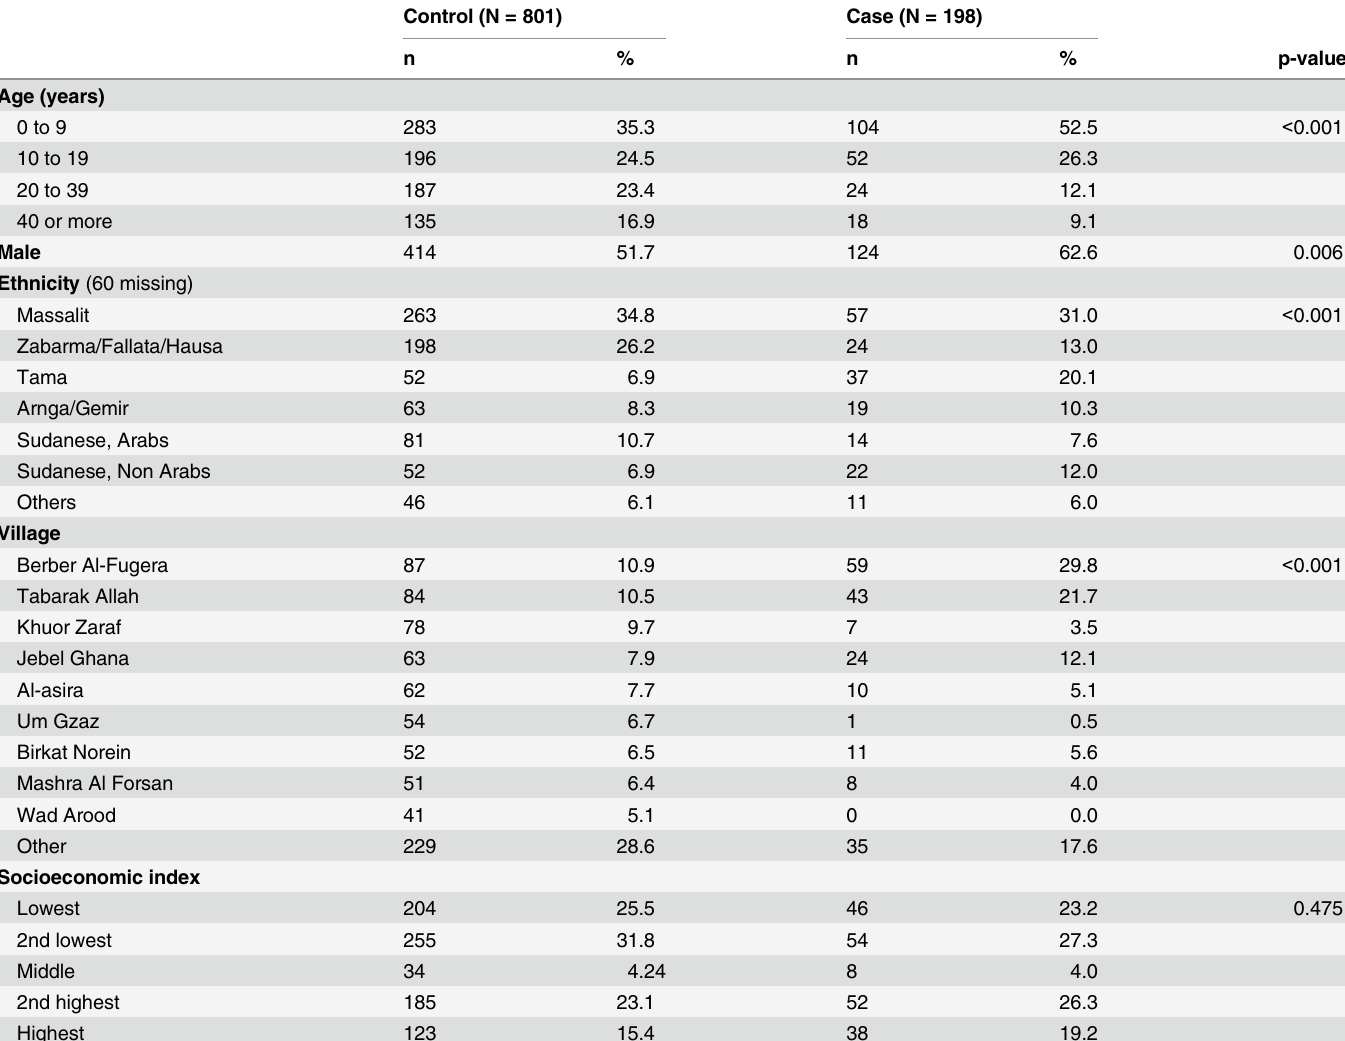
Table 1. Socio-demographic characteristics, case-control study on determinants of visceral leishmaniasis, Gedaref State, Sudan, 2012 –